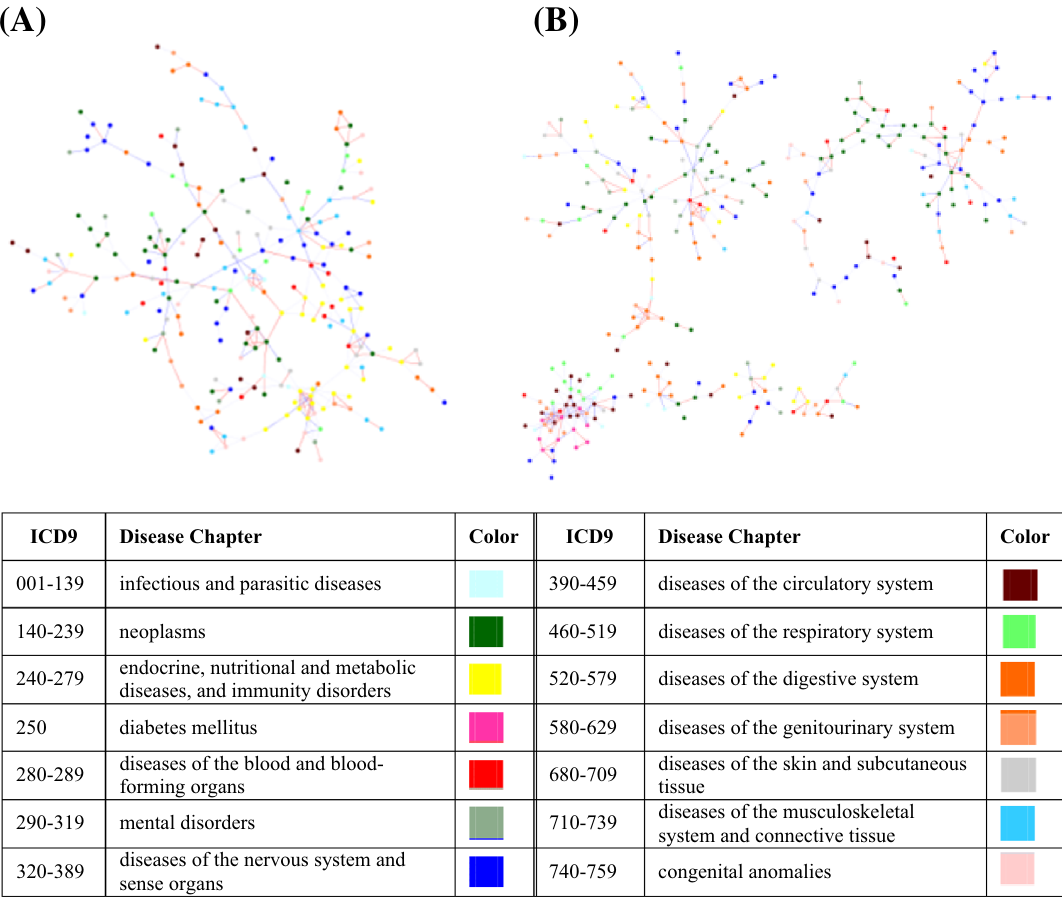
Figure 1. The PDNs of T1D for ( A ) Male and ( B ) Female inpatients. The PDN was generated using Gephi v0.9.2 29 (https:// gephi.